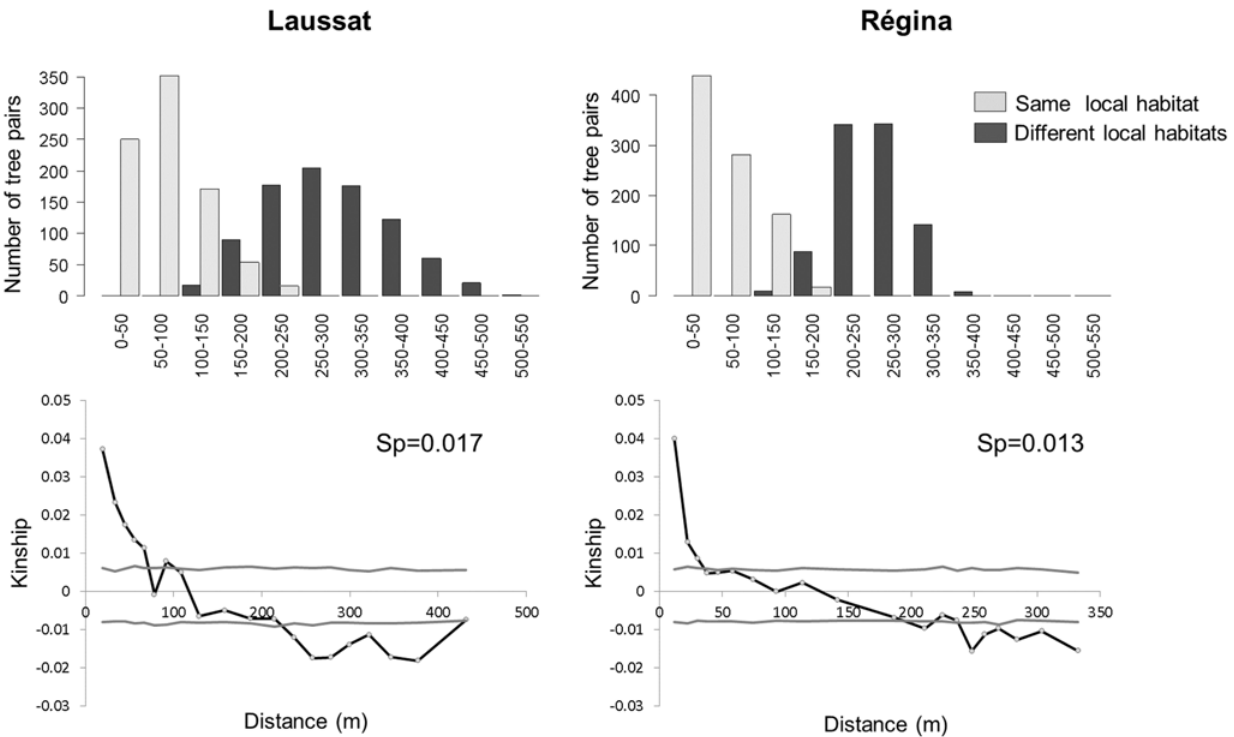
Fig 3. Top: Number of tree pairs in each distance class. Bottom: Intra-site spatial genetic structure (SGS) analysis based on all AFLP markers.